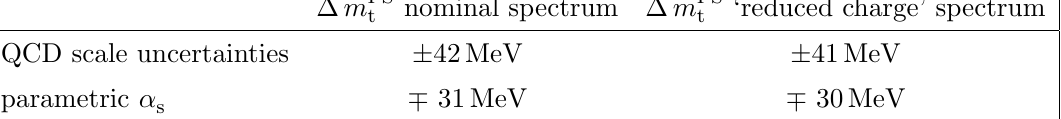
Table 5. The impact of QCD scale uncertainties at NNNLO and of uncertainties of the strong coupling constant on the measured top-quark mass in a threshold scan. The parametric uncertainty originating from the strong coupling corresponds to an uncertainty of 0.001 in (cid:11) change in mass is opposite to the sign of the change in (cid:11)